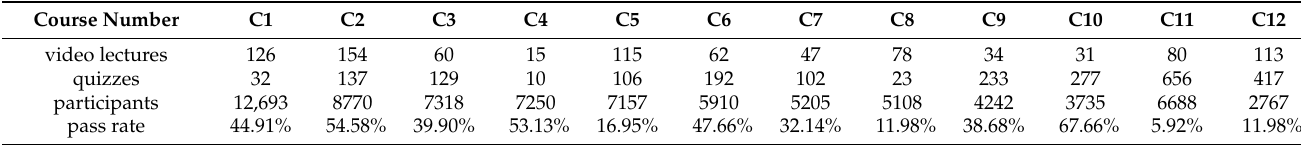
Table 1. The basic information of 12 courses.